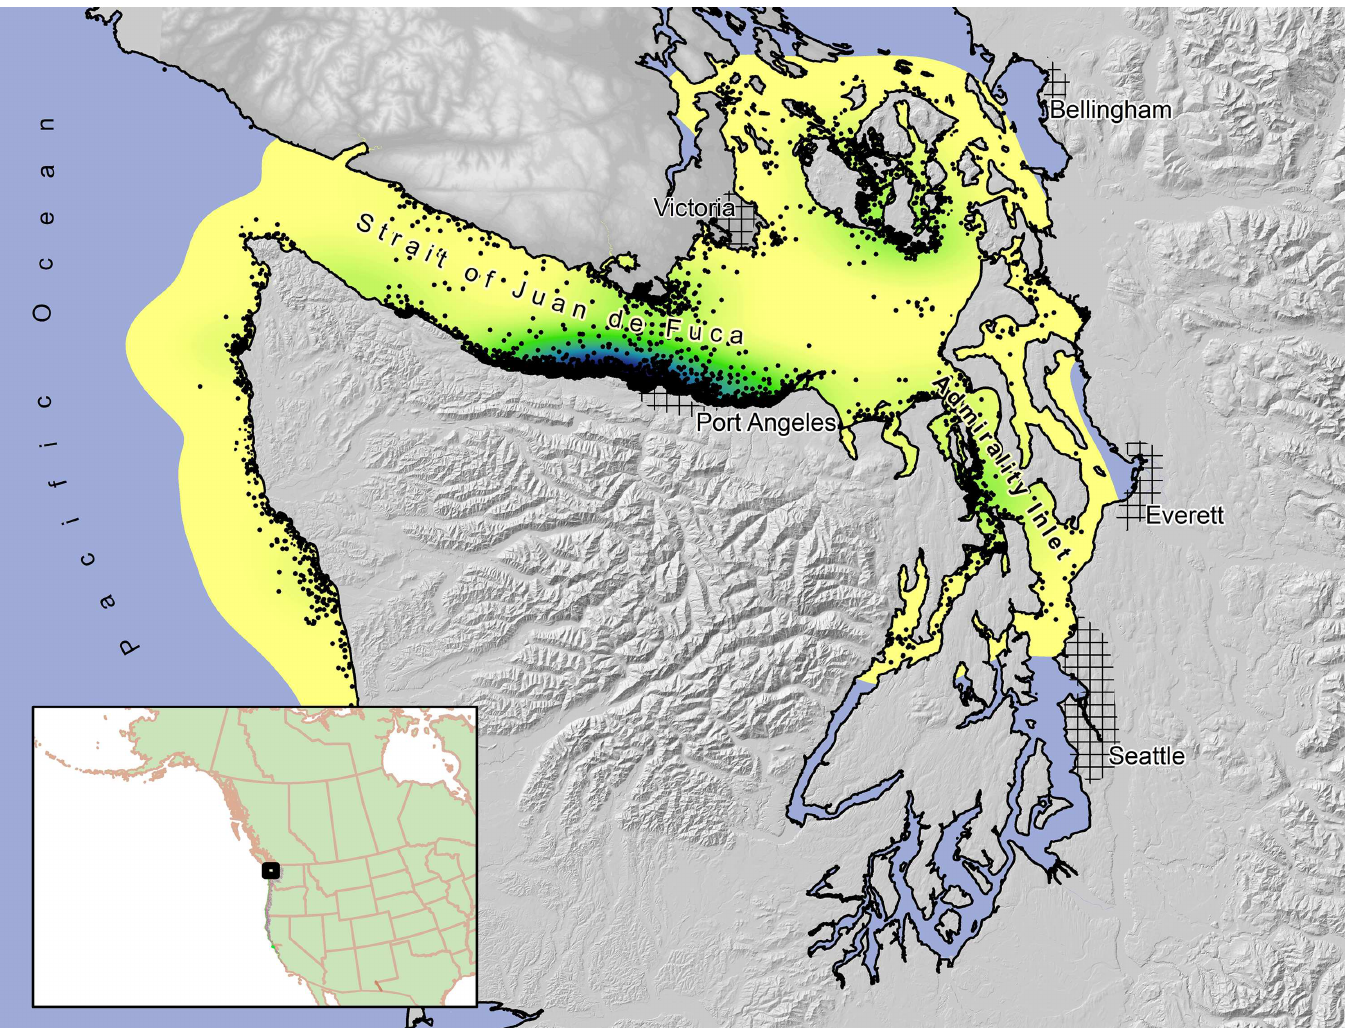
Fig 1. Study area used to examine resource selectionby marbledmurreletsin northwestern Washington and southwesternBritishColumbia, 2004–2008. The marine99% population-level kernel(fromall radio-tracked murrelets)is depictedin yellow to green tones, wheredarkershading indicates areas with a high probabilityof use and lighteryellow shading areas with a low probability of use by the populationof tagged murrelets. Black dots represent 5,388 marinetelemetrylocationsfromall murrelets tracked in this